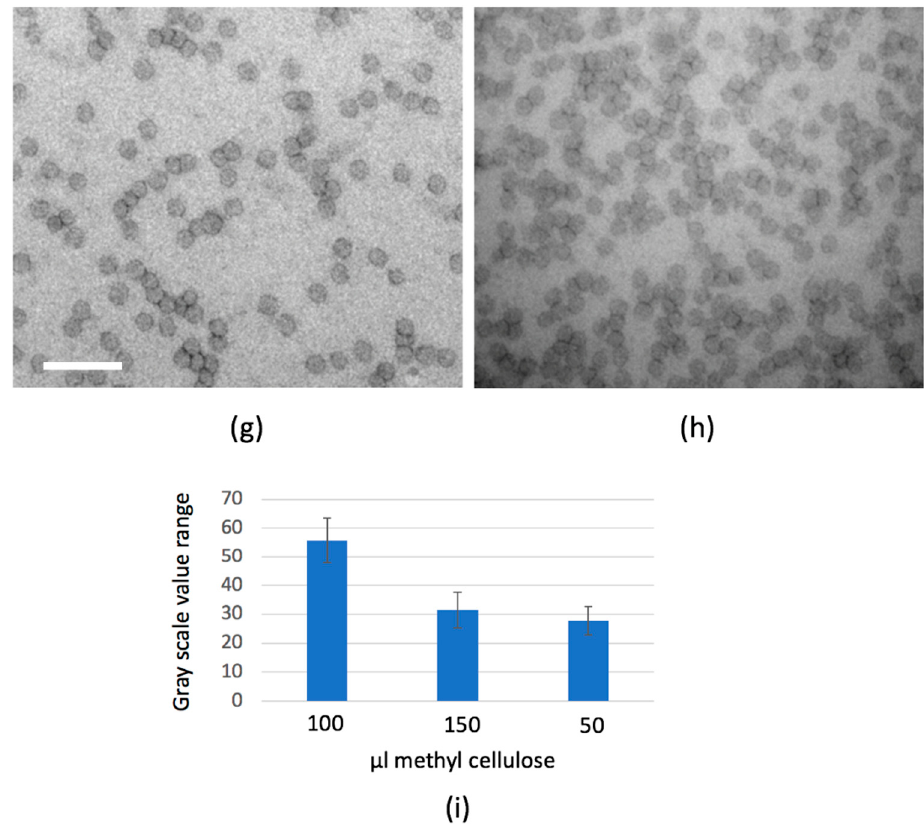
Figure 1. Optimization of mixed metal MC staining on purified low-density lipoprotein (LDL). ( a ) Negative stain using uranyl acetate (UA), see Asadi et al., [36]. ( b ) Heavy metal mix in thick methyl cellulose (MC), (800 µ L MC, 100 µ L UA, 25 µ L sodium silicostungstate (STA)). ( c ) and ( d ) Heavy metal mix in thin MC film. ( c ) 100 µ L MC, 25 µ L UA, 100 µ L STA, and 875 µ L H 2 O, and ( d ) 100 µ L MC, 50 µ L UA, 25 µ L STA, and 925 µ L H 2 O. Concentrations as described in Materials and Methods. In negative stain ( a ) edges are fuzzy while ( d ) shows positive contrast at the particle edges. ( e , f ) Show profile intensity plots from ImageJ, indicating distinct transitions at the inner surface of the particle edge density for the heavy metal mix (metal mix MC; f , arrows). In the negative stain, edge transitions (likely at the outer surface) are more difficult to define ( e , arrows). ( g–i ) Show further testing of film thickness and staining protocol for lipoproteins in a purified LDL preparation using heavy metal mix in thin MC films. ( g ) 50 µ L MC, 50 µ L UA, 25 µ L STA and 975 µ L H 2 O; ( h ) 150 µ L MC, 50 µ L UA, 25 µ L STA and 875 µ L H 2 O. ( i ) Contrast expressed as the range in grey scale values through particle edge to background as determined in ImageJ. n = 10 particles in each case; 50, 100, or 150 µ L of 2% MC in a total volume 1100 µ L, containing 50 µ L UA, 25 µ L STA, and H 2 O. Error bars are standard deviations. Scale bars 100 nm (in ( c ) for ( a – d ) and in ( g ) for ( g , h ).